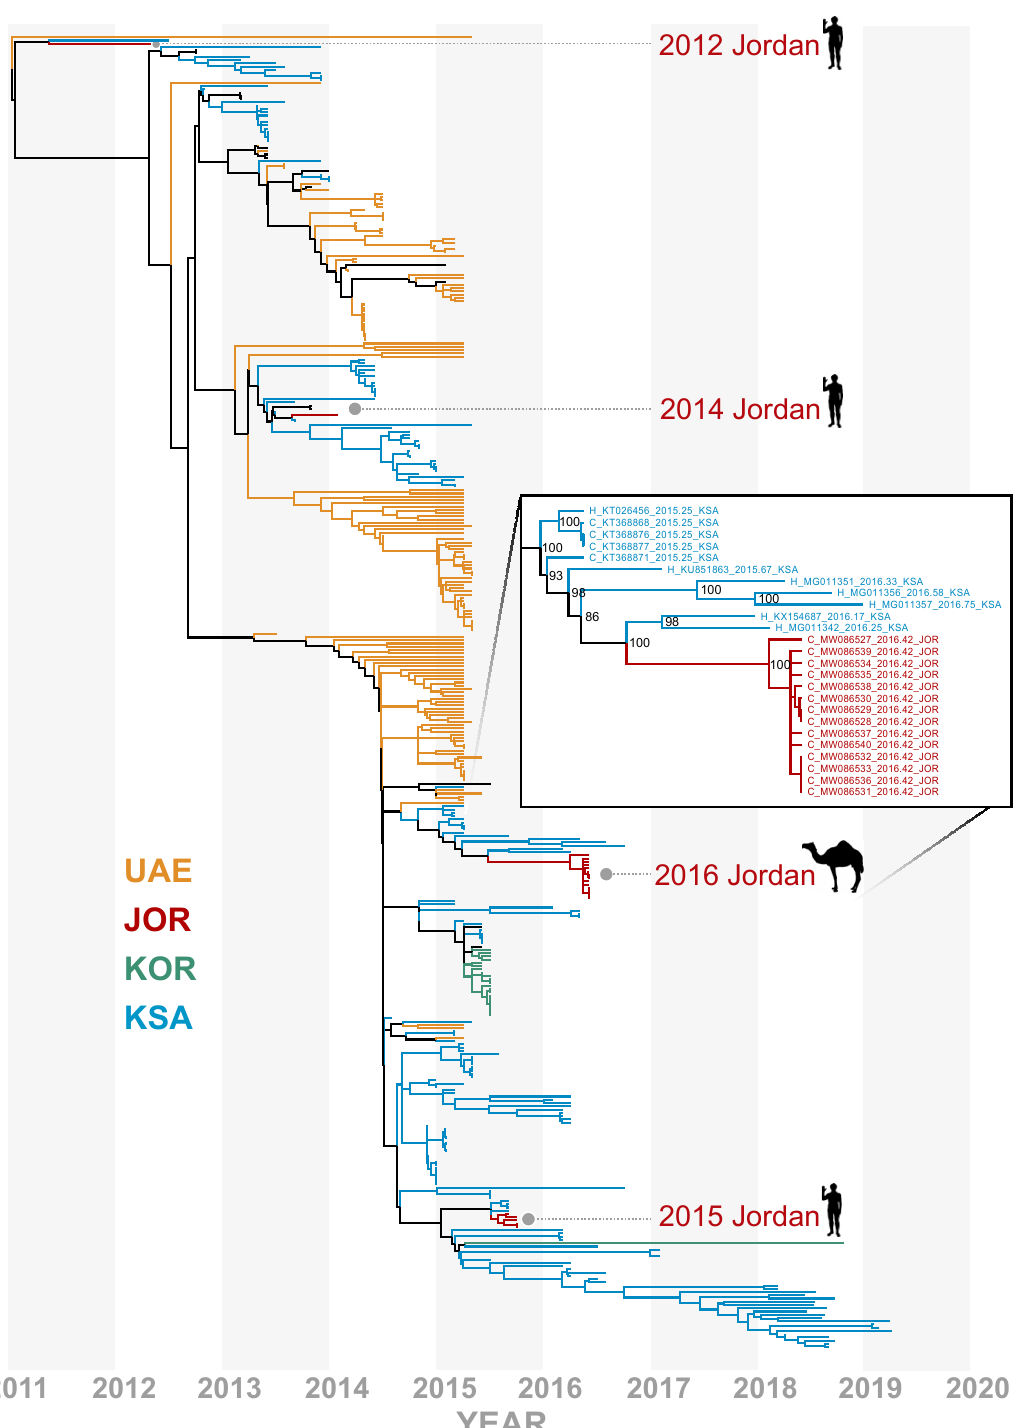
Figure 2. Time-resolved phylogenomic tree inferred from full genome sequences for 403 lineage B MERS-CoV genomes with recombinant sequences removed. Variants from United Arab Emirates (UAE) in mustard yellow, South Korea (KOR) in green, Saudi Arabia (KSA) in blue, and Jordan (JOR) in dark red. All MERS-CoV sequences originating from JOR through time are highlighted. Odd years are shown in dark-gray bands. Fourteen camel-derived MERS-CoV genomes from this study are highlighted with an inset showing bootstrap support at nodes in context of the most phylogenetically similar variants.